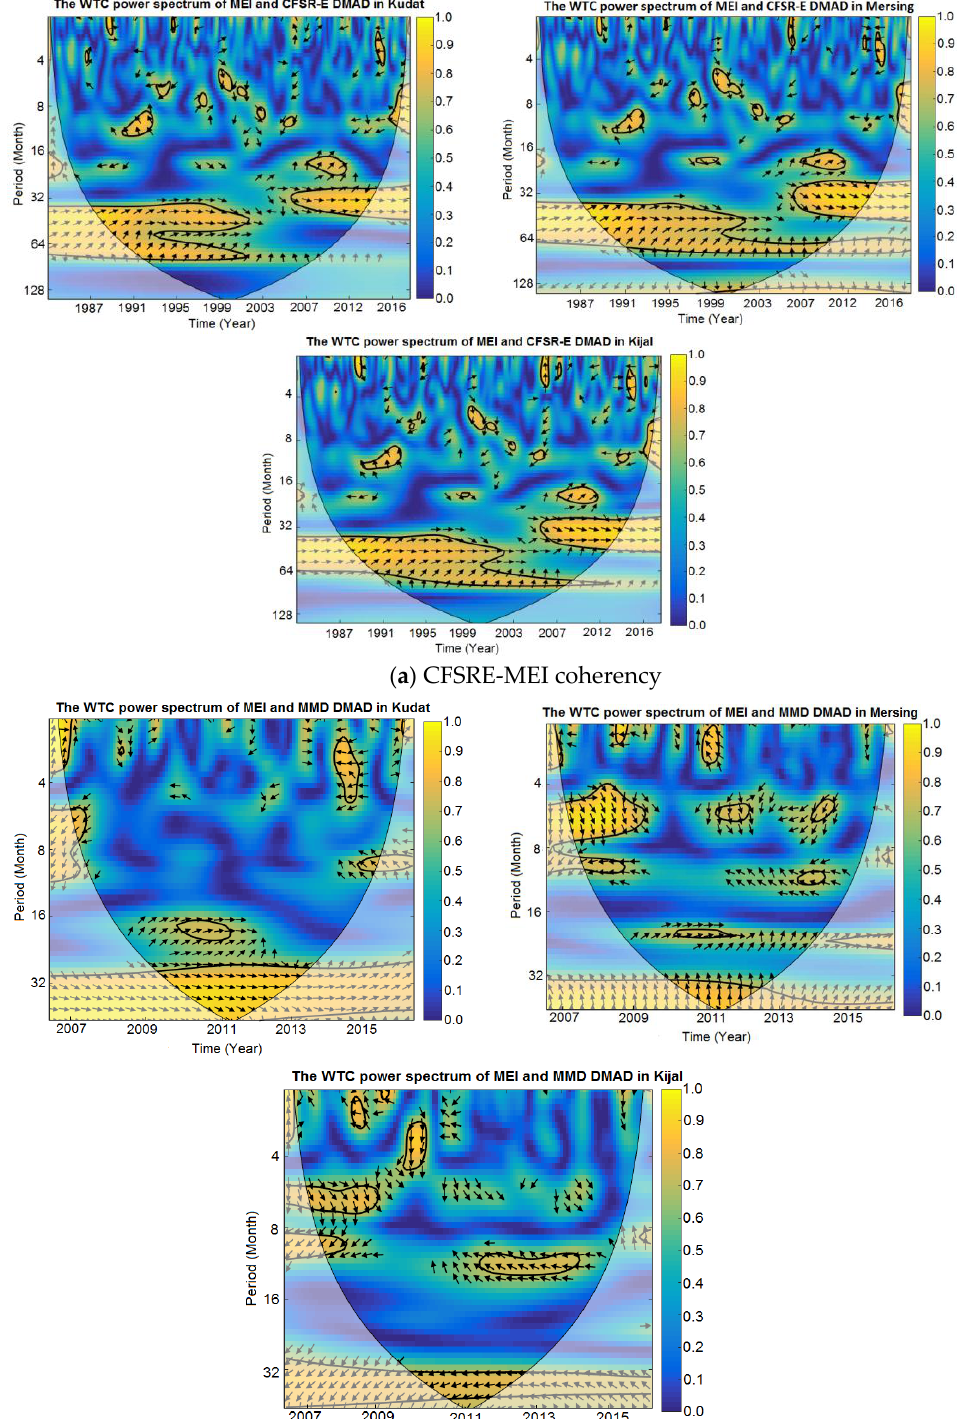
Figure 4. Wavelet coherency analysis.